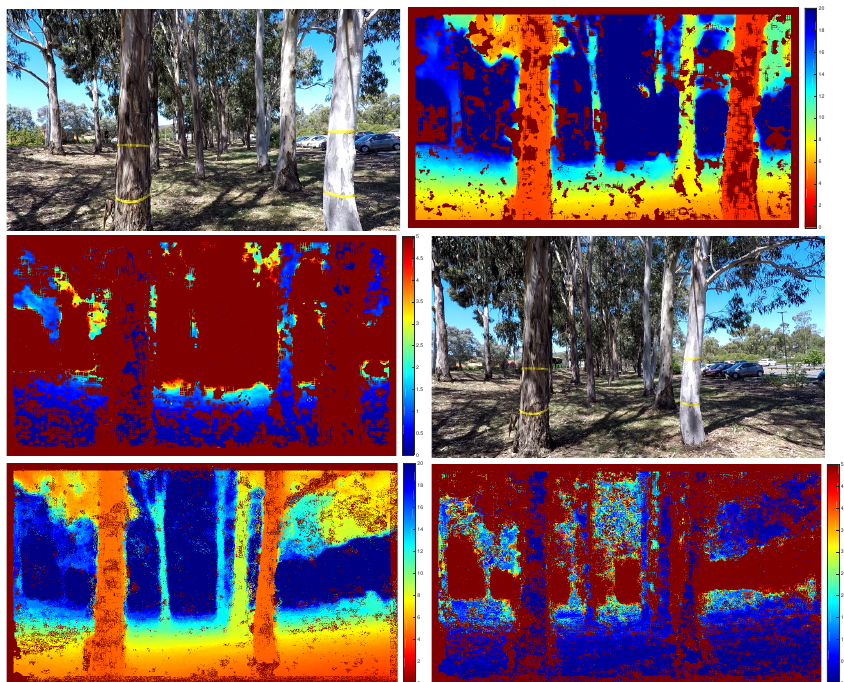
Figure 8. Estimated depth with standard deviation. From left to right: input frame, estimated depth, estimated depth standard deviation. The first row is frame 0, second row is frame 562. The scale of the colour code is in metres. Pixels that are identified as outliers are not triangulated and appear as dark red in the middle plot.